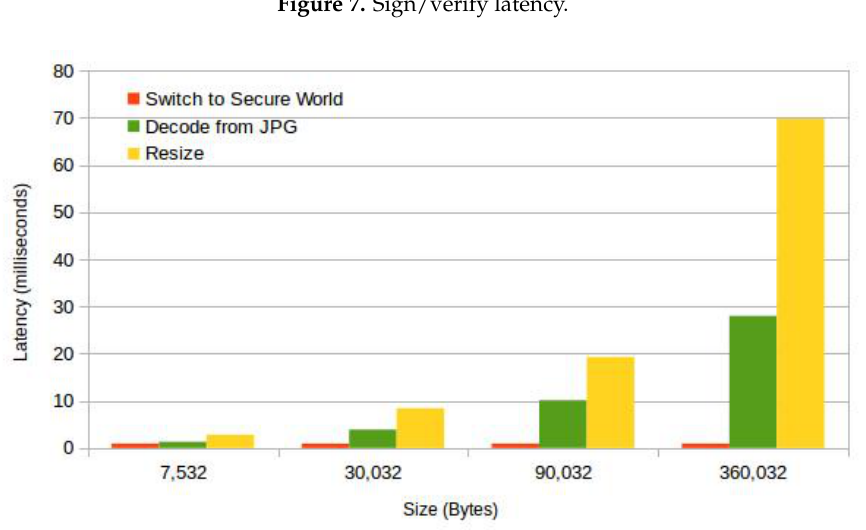
Figure 7. Sign/verify latency.